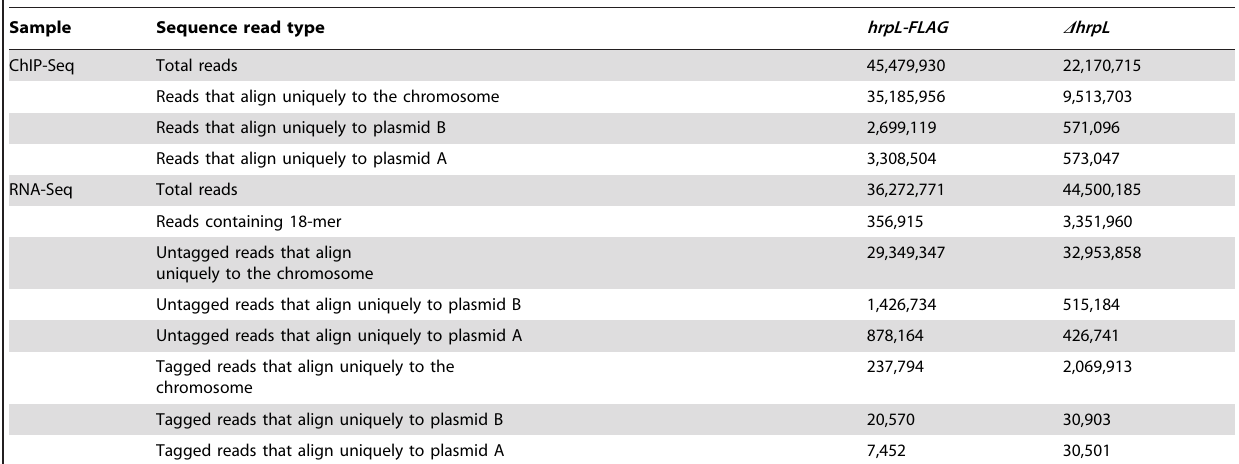
Table 2. Read mapping statistics.